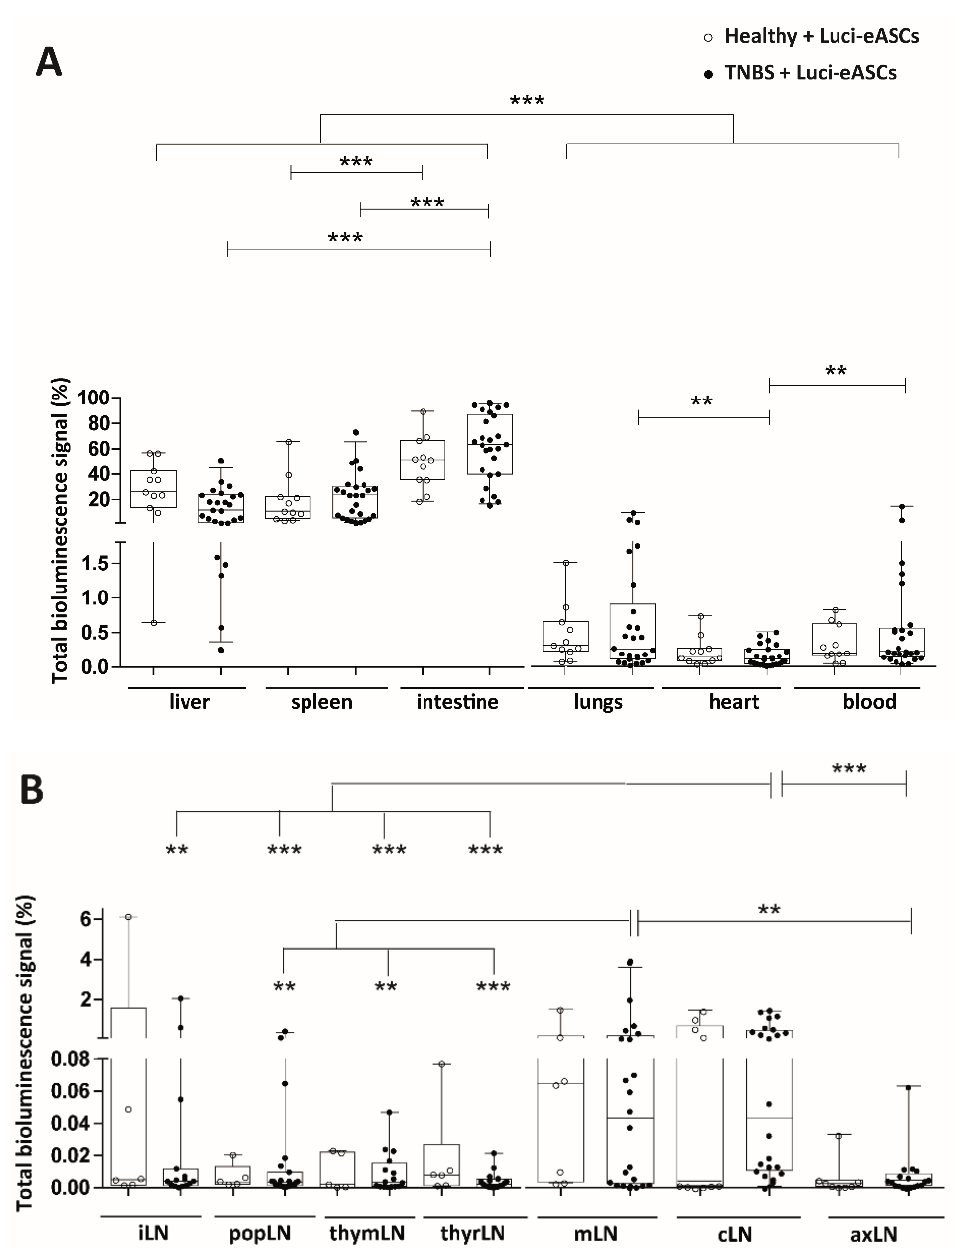
Figure 2. Analysis of bioluminescence signal in different tissues and organs (liver, spleen, intestine, lungs, heart and blood) and different lymph nodes (inguinal, popliteal, parathymic, parathyroid, mesenteric, caudal and axillary) at 48 h following IP administration of Luci-eASCs in healthy and TNBS-colitic mice. Bioluminescence signals measured at 48 h in the liver, spleen, intestine, lungs, heart and blood ( A ) and in the inguinal (iLN), popliteal (popLN), parathymic (thymLN), parathyroid (thyrLN), mesenteric (mLN), caudal (cLN) and axillary (axLN) lymph nodes (LNs). ( B ). Data were expressed as percentage of light units per tissue relative to the total number of light units per mouse. Healthy + Luci-eASCs intraperitoneal (IP), n = 11; TNBS + Luci-eASCs IP, n = 26. Data are presented by dots and box-plots that represent the interquartile range (p75, upper edge; p25, lower edge; p50, midline; p95, line above the box, and p5, line below the box) of the percentage of total bioluminescence signal. Significance was analyzed by the Mann–Whitney U test and represented by ** p < 0.007 and *** p < 0.001. Results correspond to four independent experiments.